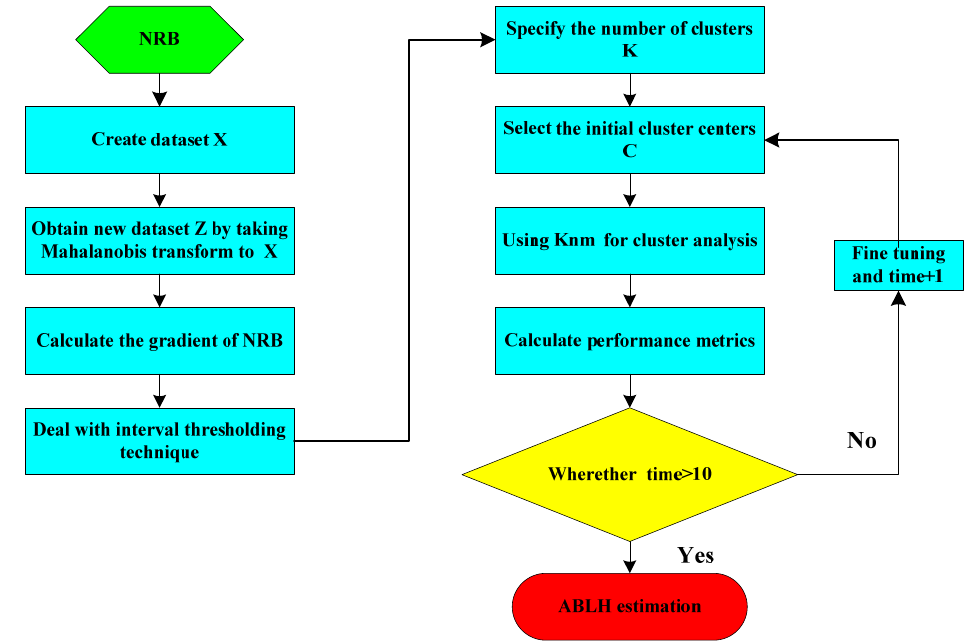
Figure 5. Flowchart of ABLH estimation by MKnm from LiDAR data.